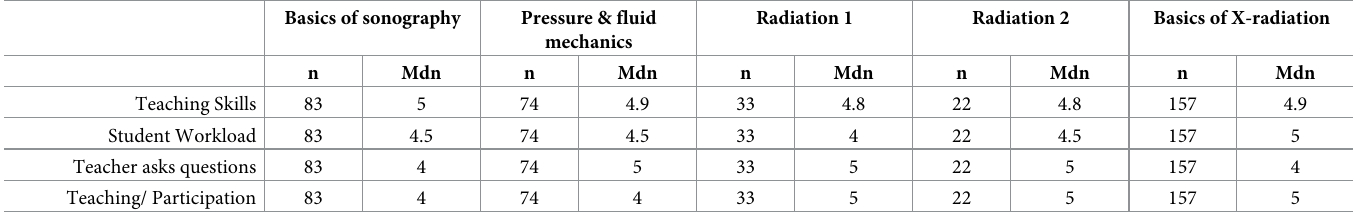
Table 2. Descriptive statistics of the SETMED-L